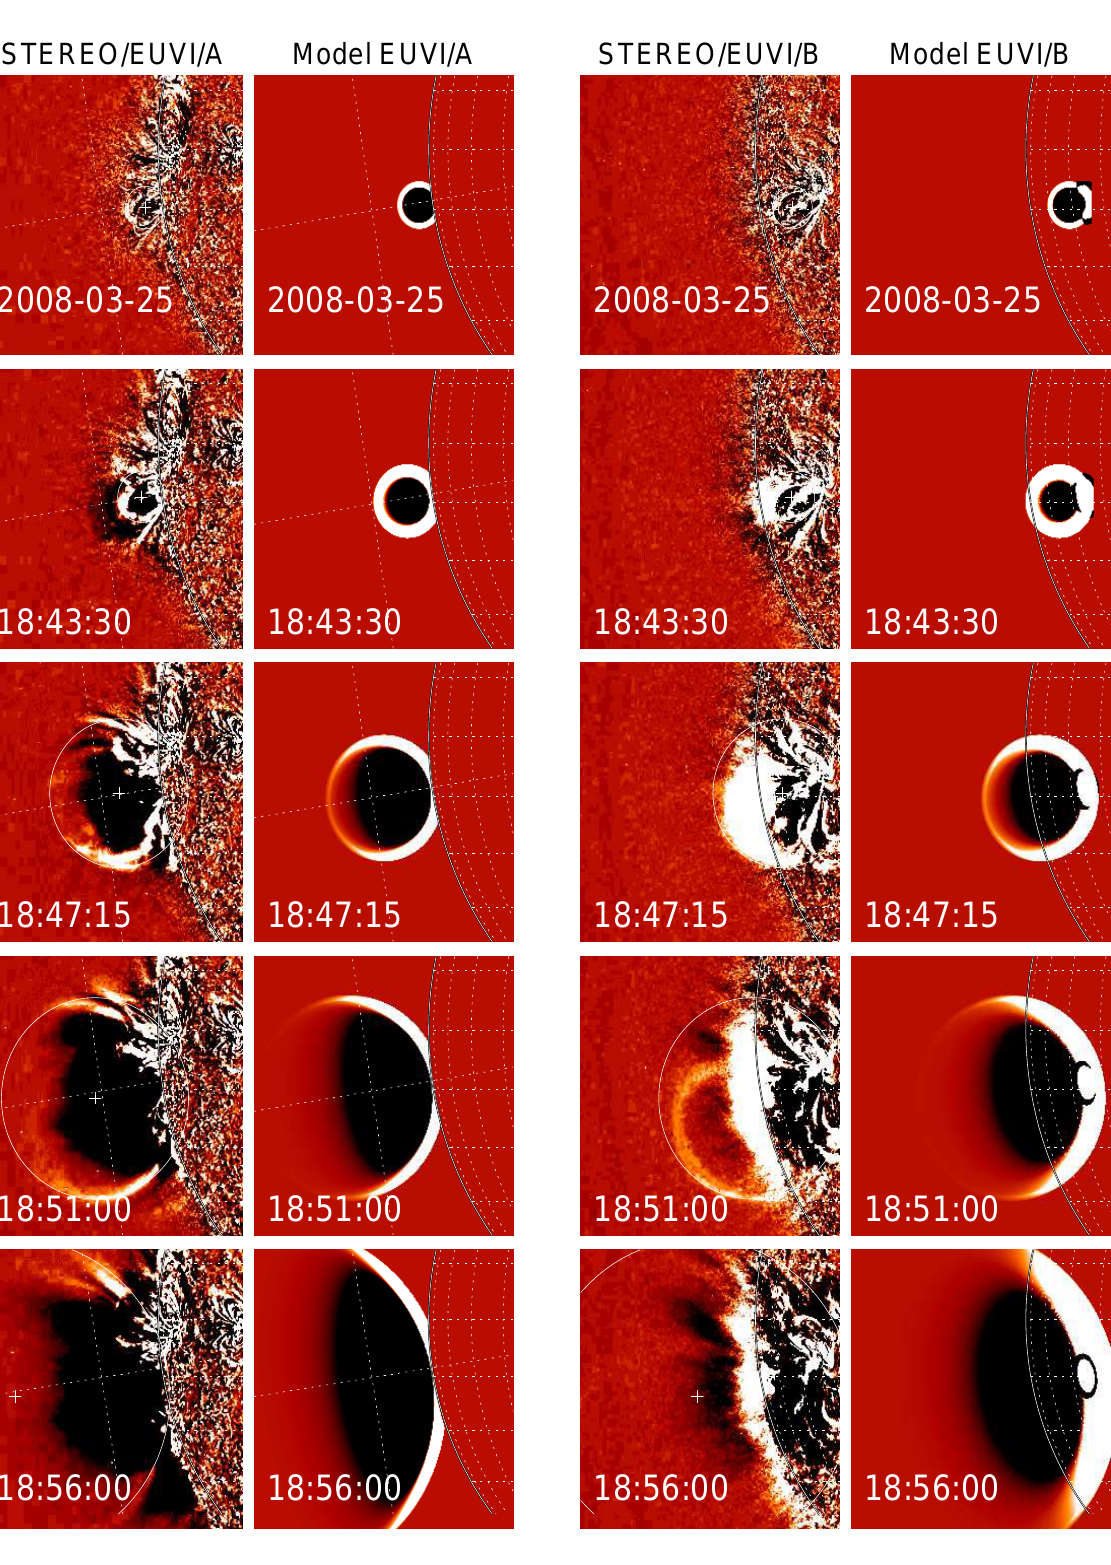
Fig. 6. Comparison of observed and simulated EUVI base-difference images at 5 times for the observations of STEREO/A 171 ˚A (left two columns) and STEREO/B 171 ˚A (right two columns). The pre-CME image at 18:36UT was subtracted in these base-difference